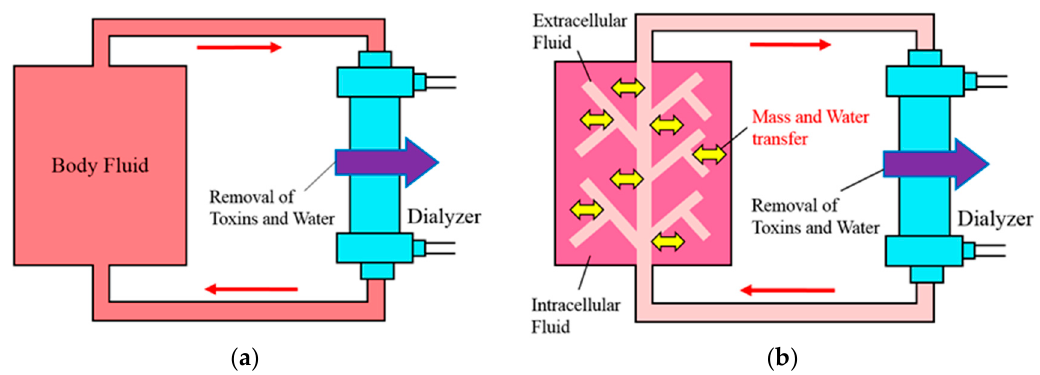
Figure 1. Pool model images for assessing the toxin concentration in the body during dialysis; ( a ) shows single-compartment model for which a whole body is a contaminated pool, while ( b ) shows the two-compartment model where the body is divided into intracellular and extracellular fluids.